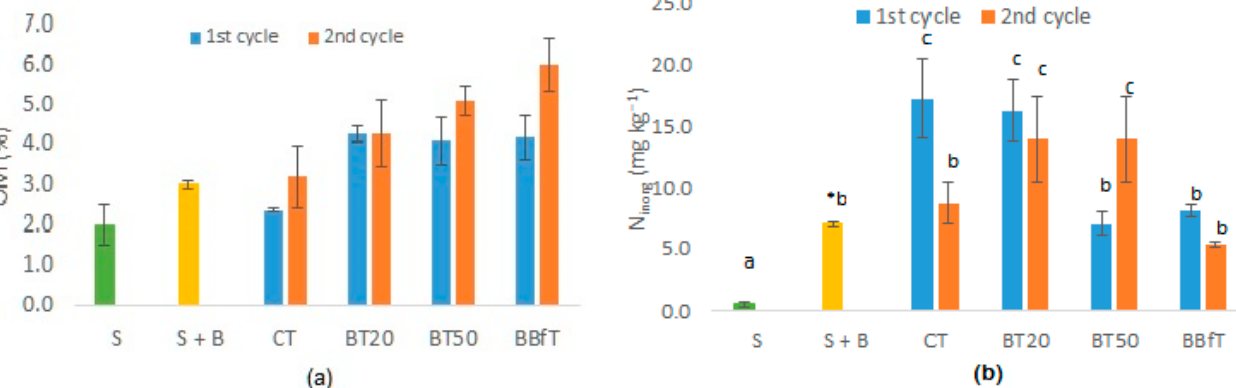
Figure 3. ( a ) Organic matter (OM) and ( b ) inorganic nitrogen (N inorg ) of the studied soil (S), with biochar (S + B), and with different treatments: CT: soil + 100% chemical fertilization, BT20 and BT50: soil + biochar +, 20, or 50% of chemical fertilization, respectively, and BBfT: soil + biochar + biofertilization. Different letters and * indicate significant difference ( p < 0.05, Duncan test and one-way ANOVA, respectively).